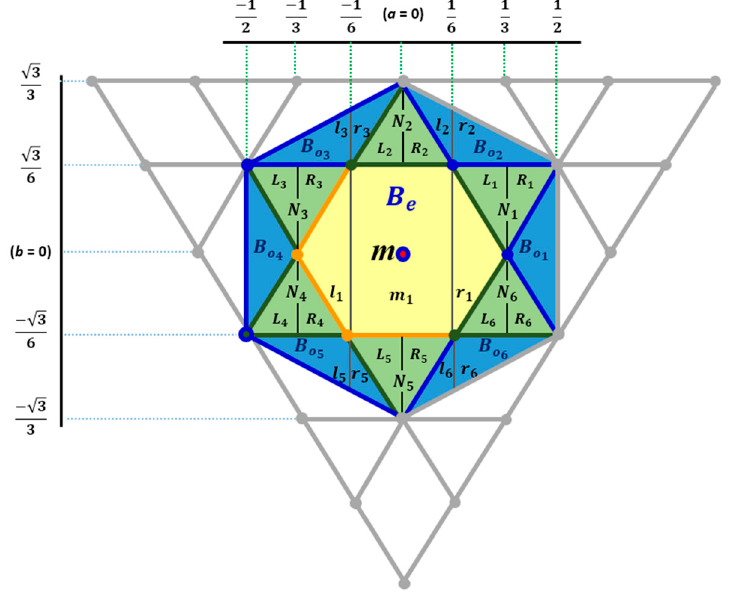
Figure 7. An even pixel with its three closest neighbors. The hexagon region B e (in yellow color) with its orange borders is referred to as the strongly-bijective translation region, whereas the six obtuse-angle triangles B o where i = 1 ... 6 (in blue color with its dark blue borders) are referred to as the semi-bijective translation regions. The six equilateral triangles N i where i = 1 ... 6 (in green color with its dark green borders) are referred to as the non-bijective translation regions (the starting point of the fractional part of the translation vector is at the even midpoint ( m )).